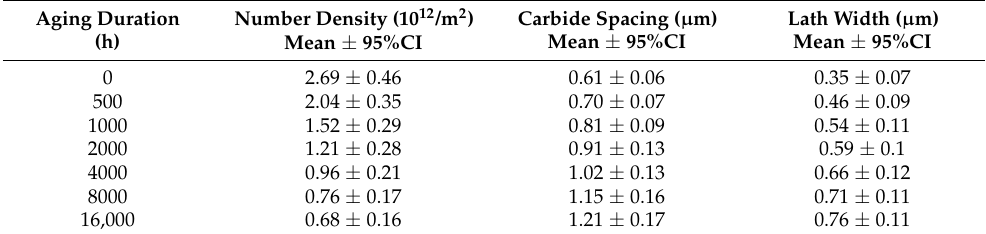
Table 3. Number density and spacing of the precipitations and martensitic lath width of the aged samples.